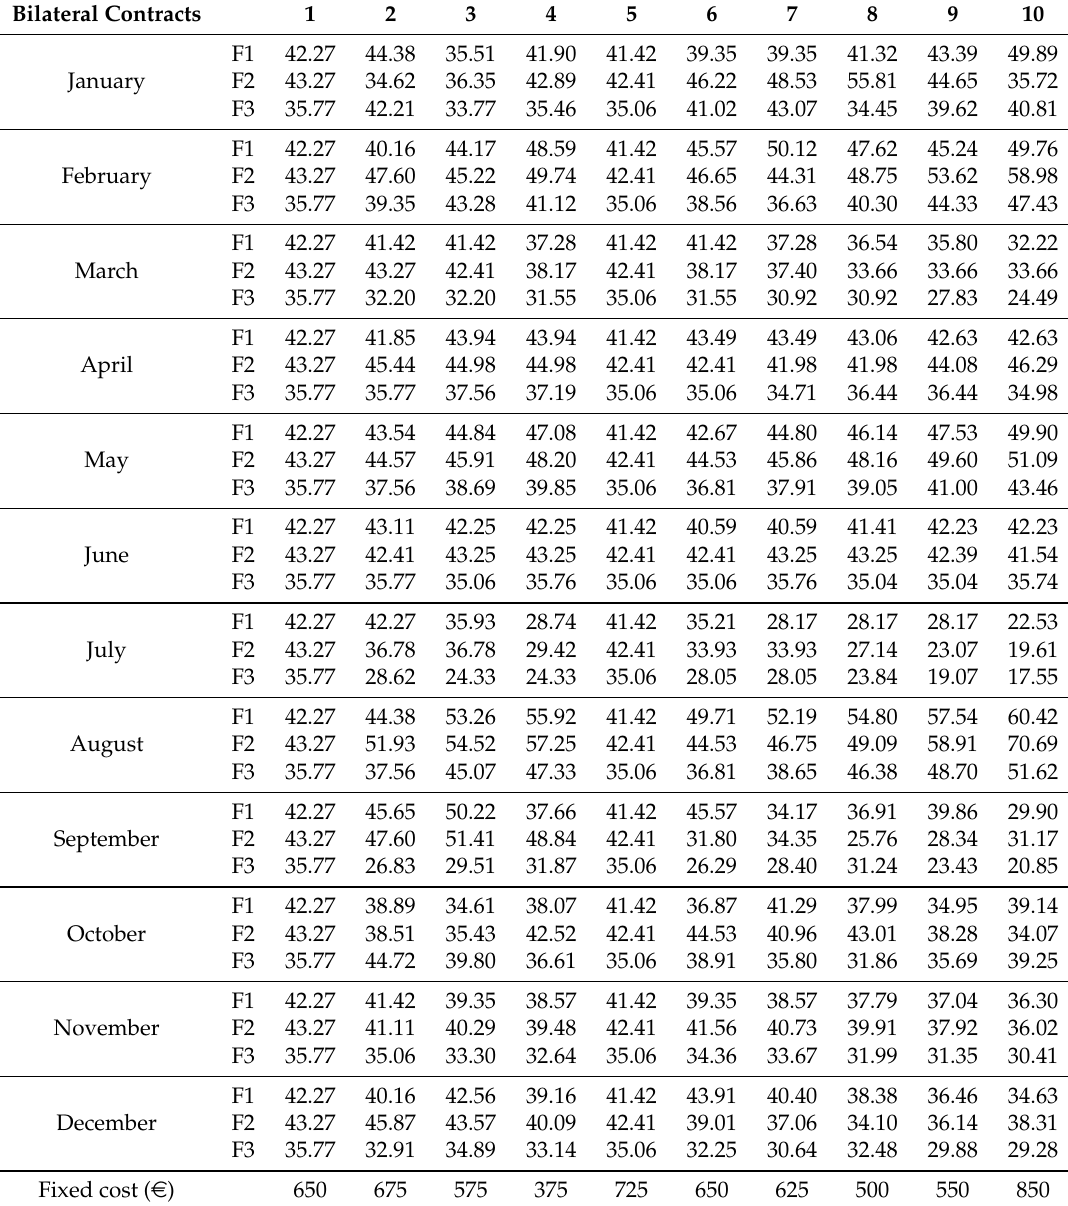
Table A2. Bilateral contracts unit price ( e /MWh) and fixed cost ( e